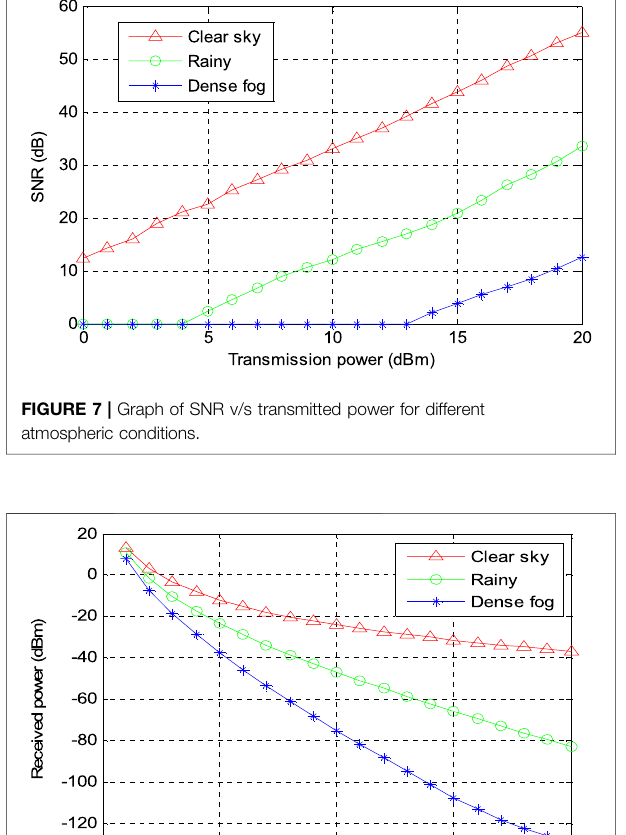
FIGURE 10 | Relationship between received BER and link distance at various atmospheric conditions with